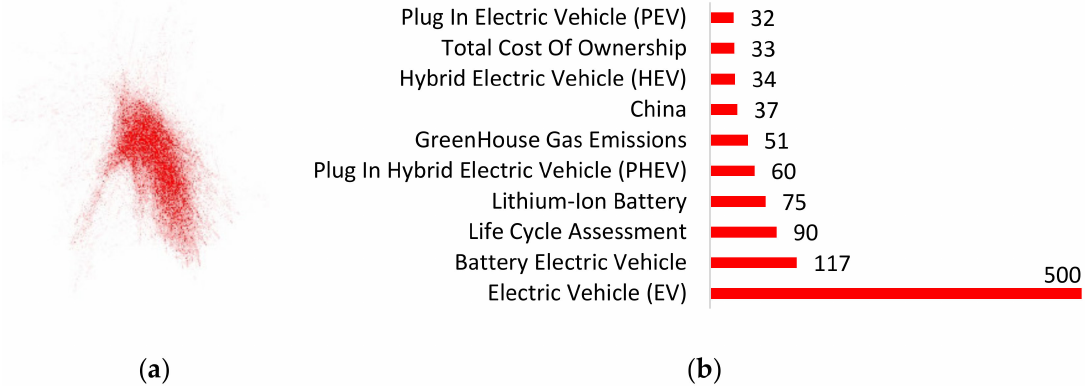
Figure 7. Representation of the EV Market Study community: ( a ) isolated distribution of publications; ( b )